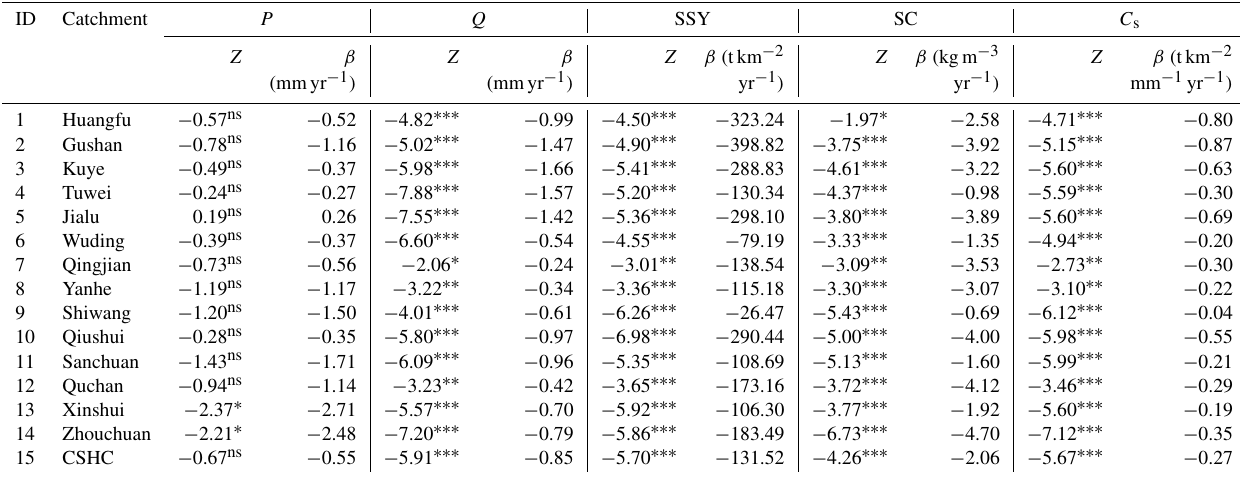
Figure 6. Long-term trends in growing season LAI changes over (a) 1982–2011, (b) 1982–1999, and (c) 2000–2011 in the study area. The inset in each figure shows the frequency distribution of the LAI trends. Table 2. Mann–Kendall trend analysis results for the annual precipitation ( P ), streamflow ( Q ), specific sediment yield (SSY), sediment concentration (SC), and sediment coefficient ( C s ) during